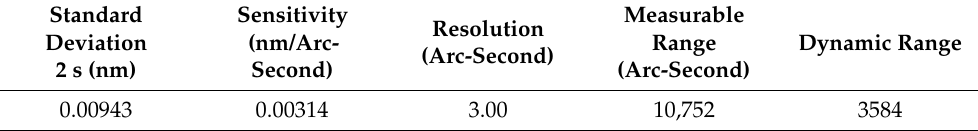
Figure 8. The sensitivity of the peak wavelength to the angular displacements.